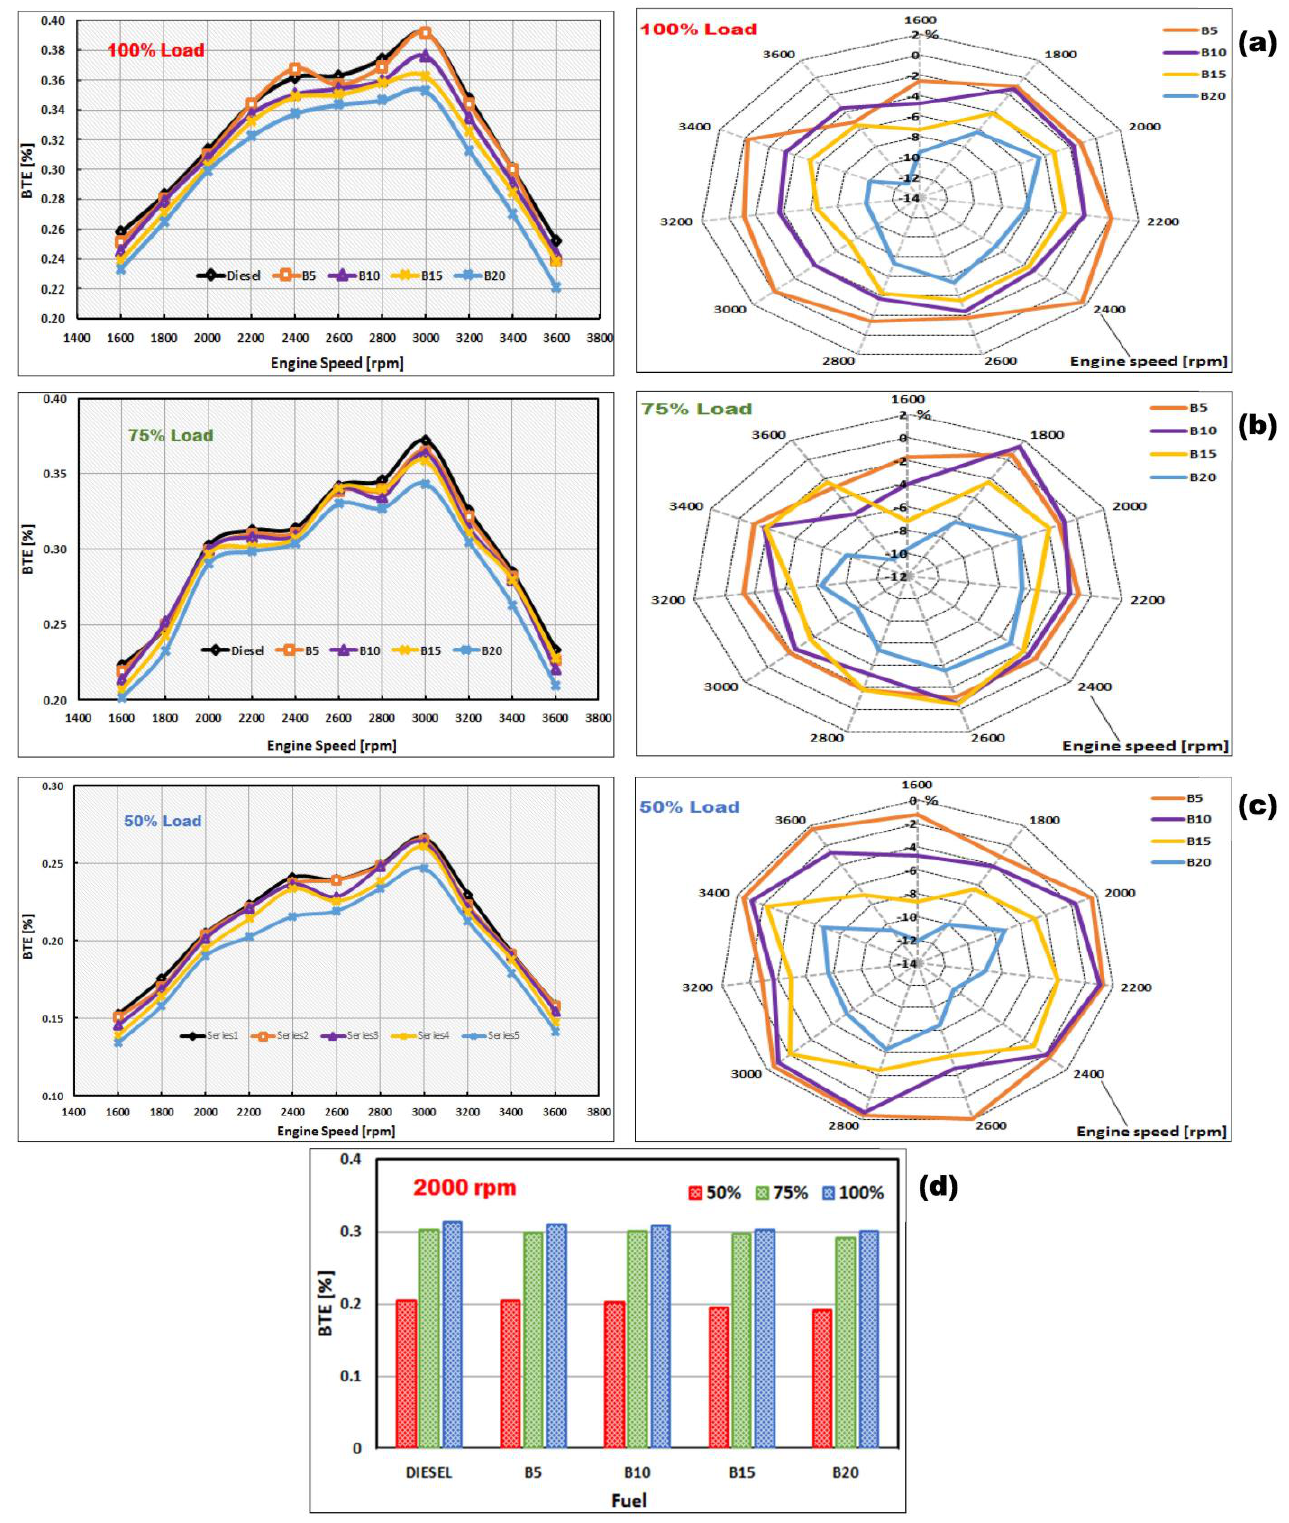
Figure 7. Brake thermal efficiency variation with engine speed, presented as trends (left) and normalized value contours (right) for ( a ) 100% load, ( b ) 75% load, and ( c ) 50% load; ( d ) compares all fuels and loads at 2000 rpm.